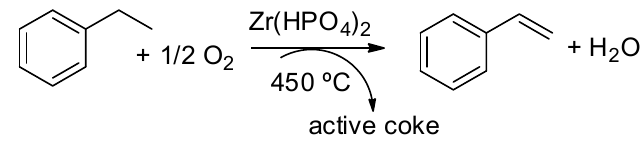
Figure 5. Catalytic oxidative dehydrogenation of ethylbenzene to styrene and formation of active coke.